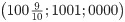
Analytical pairwise comparison of iPD strategies.For each pair of strategies the maps show if the first of the two strategies increases in frequency (up-arrow), or decreases (down-arrow) depending on visibility of the other player’s action and the already existing fraction of the respective strategy. The red lines mark the invasion thresholds, i.e. the minimal fraction of the first strategy necessary for taking over the population against the competitor second strategy. A solid-line invasion threshold shows the stable equilibrium fraction which allows coexistence of both strategies (see “Methods”). Dashed-line invasion thresholds indicate dividing lines above which only the first, below only the second strategy will survive. (A) WSLS (100910;1001;0000) has an advantage over GTFT (113113;113113;0000): the former takes over the whole population even if its initial fraction is as low as 0.25. (B) GTFT coexists with (prudent) version of cooperative strategy AllC (1111; 1111; 0000), which is more successful for psee ≥ 0.1. (C,D) L-F (13000;23000;11113) performs almost as good as GTFT and WSLS, (E) but can resist the AllD strategy (0000; 0000; 0000) only for high transparency. (F) Note that WSLS may lapse into its treacherous version, (100910;0000;0000). This strategy dominates WSLS for psee > 0 but is generally weak and cannot invade when other strategies are present in the population. Notably, when treacherous WSLS takes a part of the population, it is quickly replaced by L-F, which partially explains L-F success for high psee.